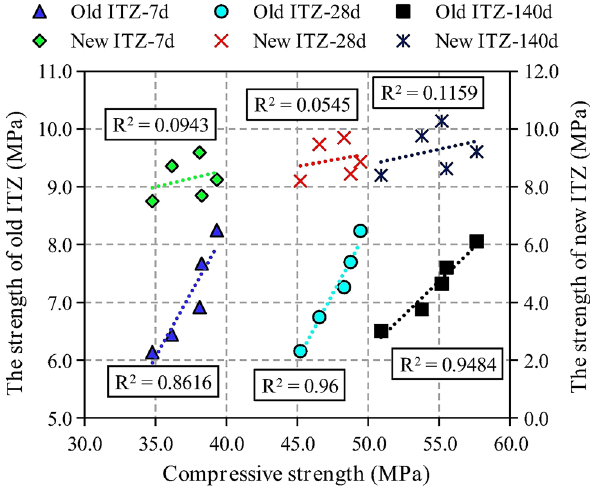
Figure 14: Relationship between strength of ITZ and compressive strength [ 71 ]